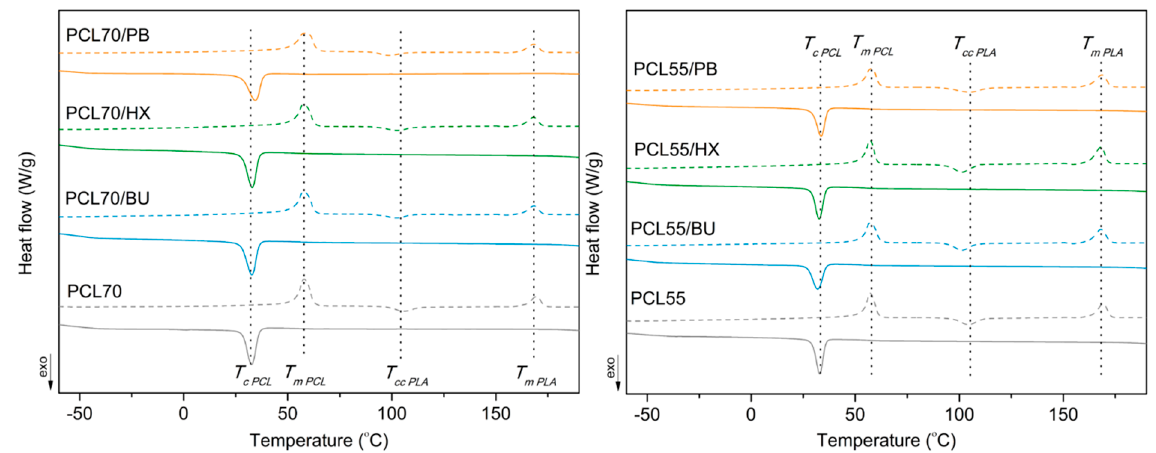
Figure 4. DSC curves of the second heating for PCL/PLA blends. Table 3. DSC parameters (2nd heating) of PCL/PLA blends and PCL/PLA modified by OP. Sample